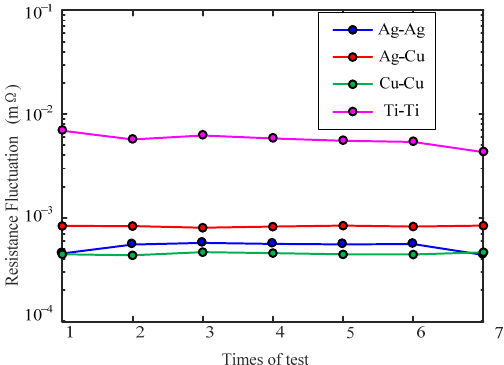
Figure 9. Contact resistance fluctuation curves of different electrode materials.